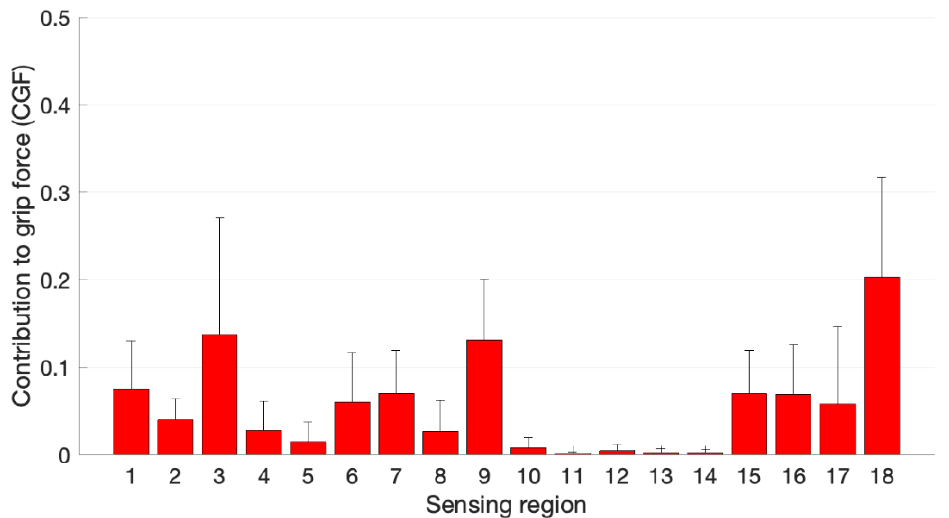
Figure 9. Contribution to grip force (CGF) for the different sensing regions (1 – 18) as average of the mean value for each task. The lines indicate the standard deviation.